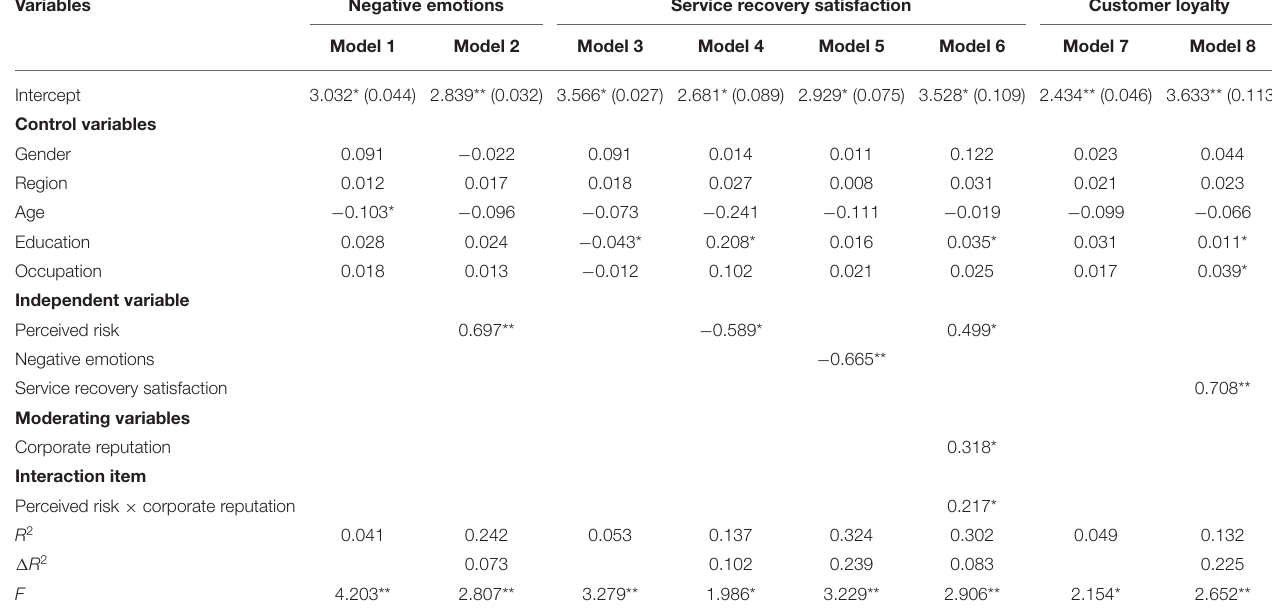
TABLE 5 | Multilevel regression analysis.